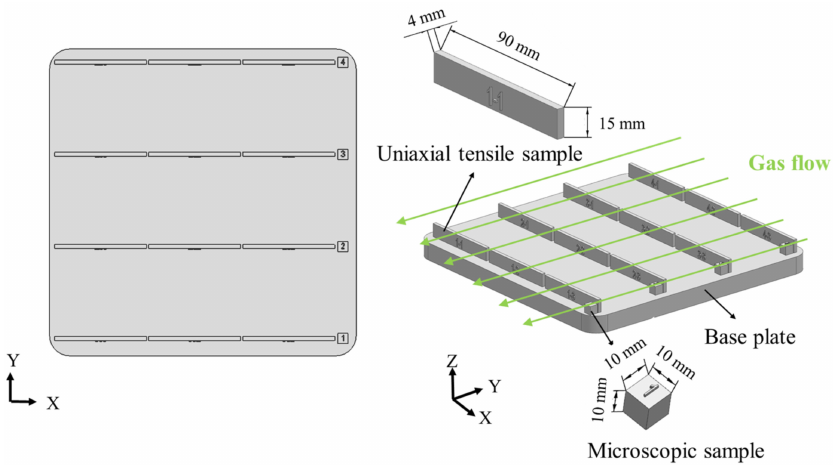
Figure 3. The CAD model of the test